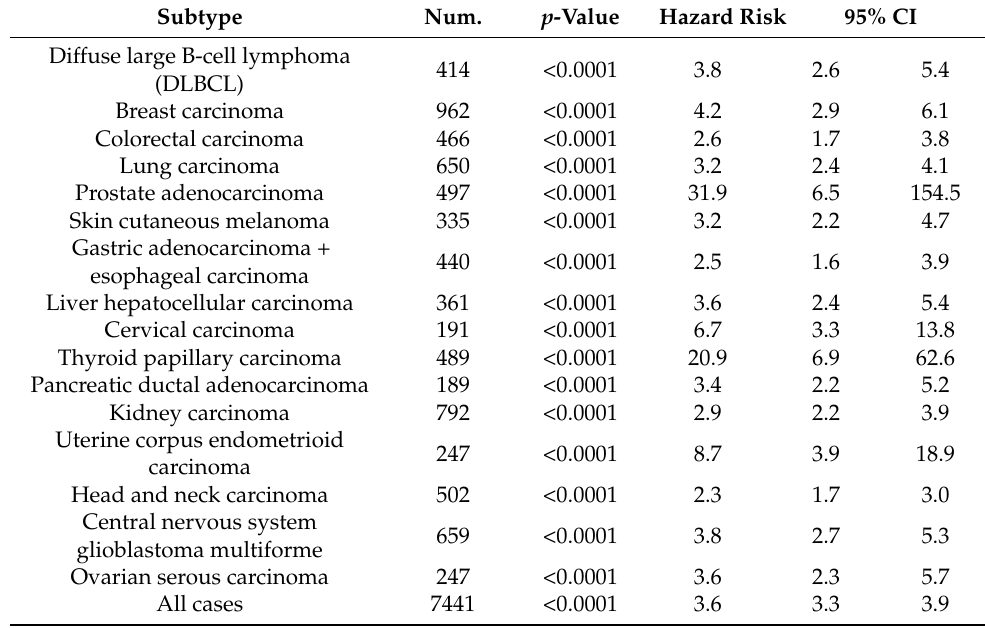
Table 6. Overall survivals according to the top 30 genes.